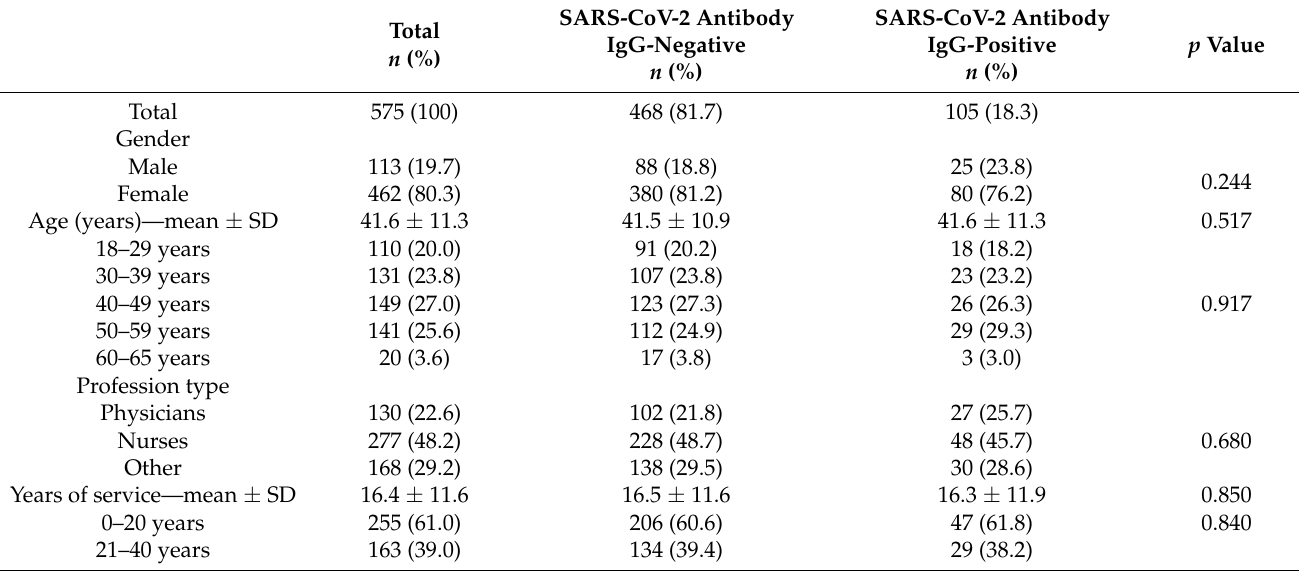
Table 1. Demographic and SARS-CoV-2 testing